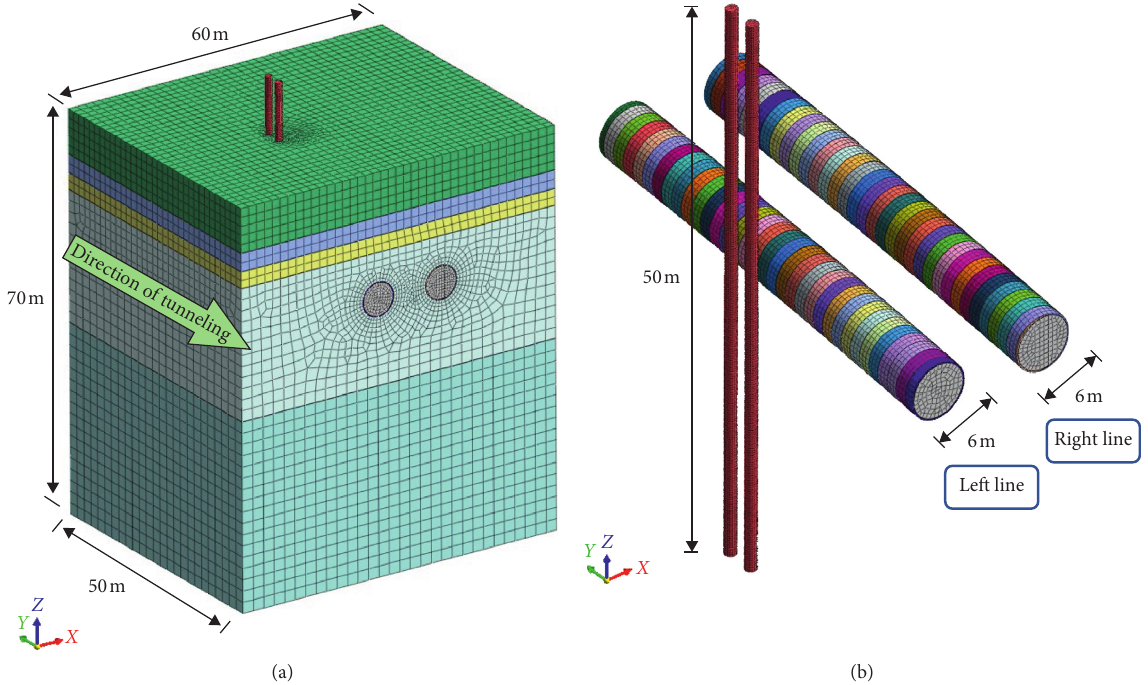
Figure 7: Three-dimensional finite element model. (a) Global model. (b) Relationship between the pile and tunnel.